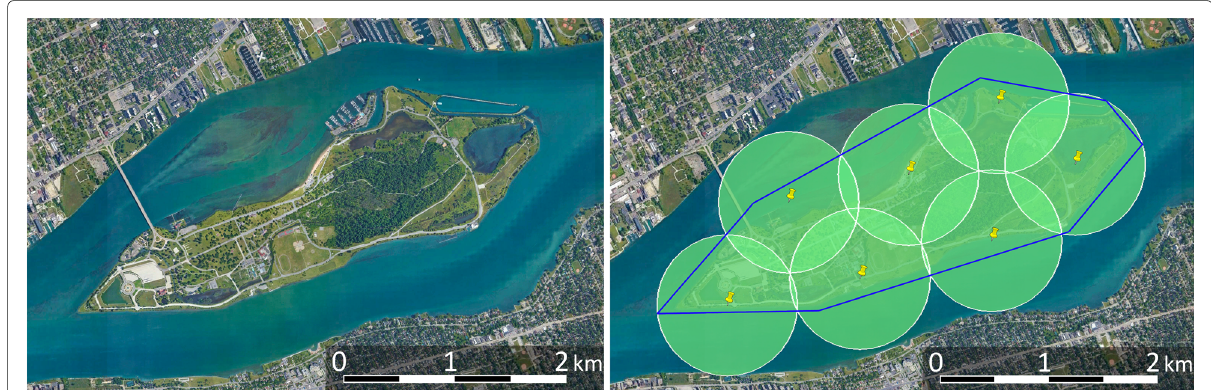
Fig. 1 Left: The Belle Isle island located between Detroit, USA to the north and Windsor, Canada to the south. Right: A 7-center solution covering the island’s convex envelope. The circle radius is 665 m, meaning that a drone operating over this 1000-acre island is within 665 m of a safe landing spot at all